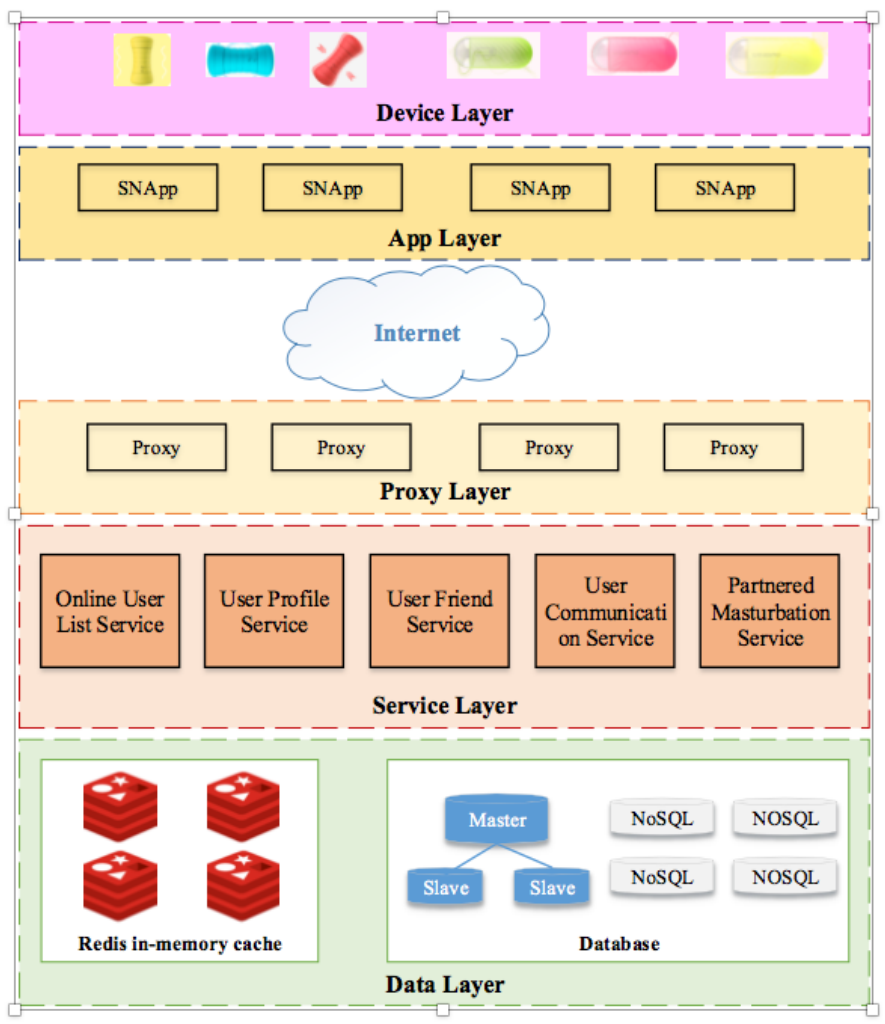
Figure 2. The overall system architecture of the sexual behavior acquisition (SeBA)